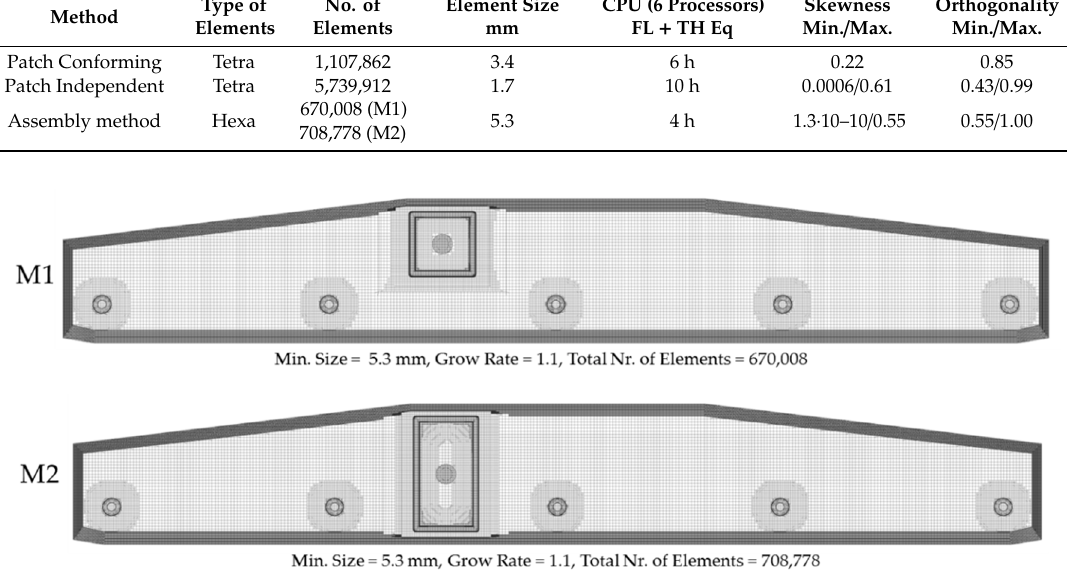
Table 7. The statistics of used mesh during setting validation of the numerical model.